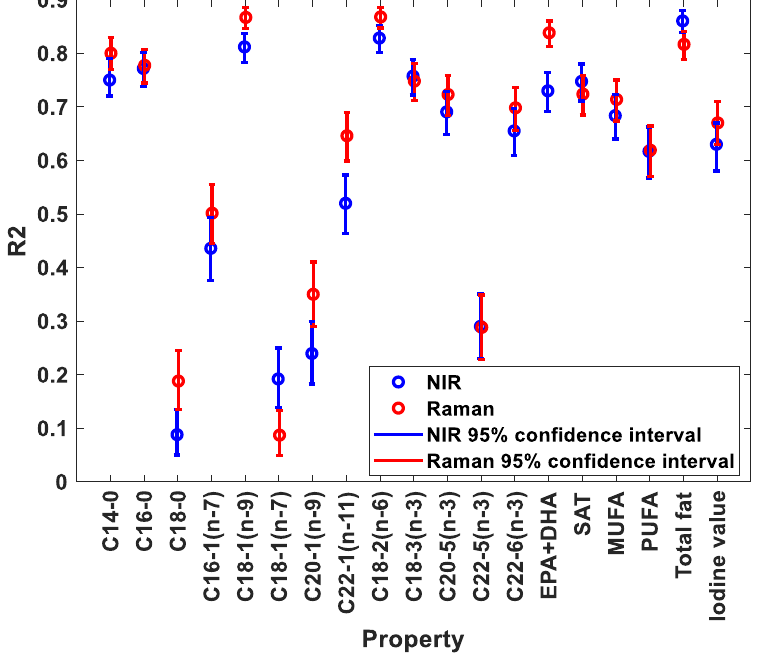
Figure 2. R 2 values of predicted FAs as percentage of fat for NIR and Raman spectroscopy.